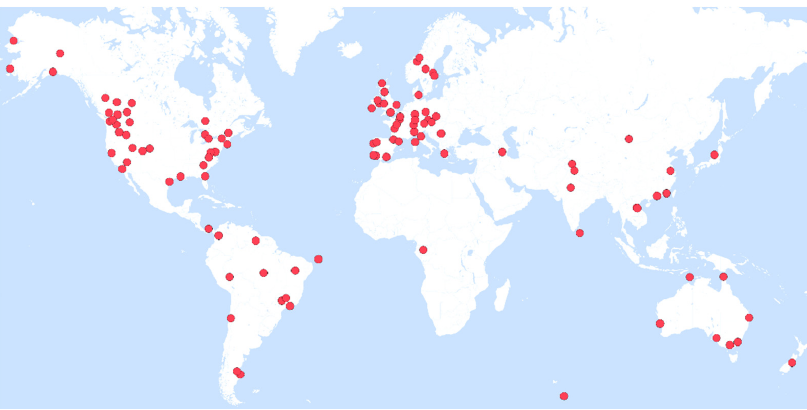
Figure 2. Locations of the field or laboratory work of the 113 studies identified in this study.